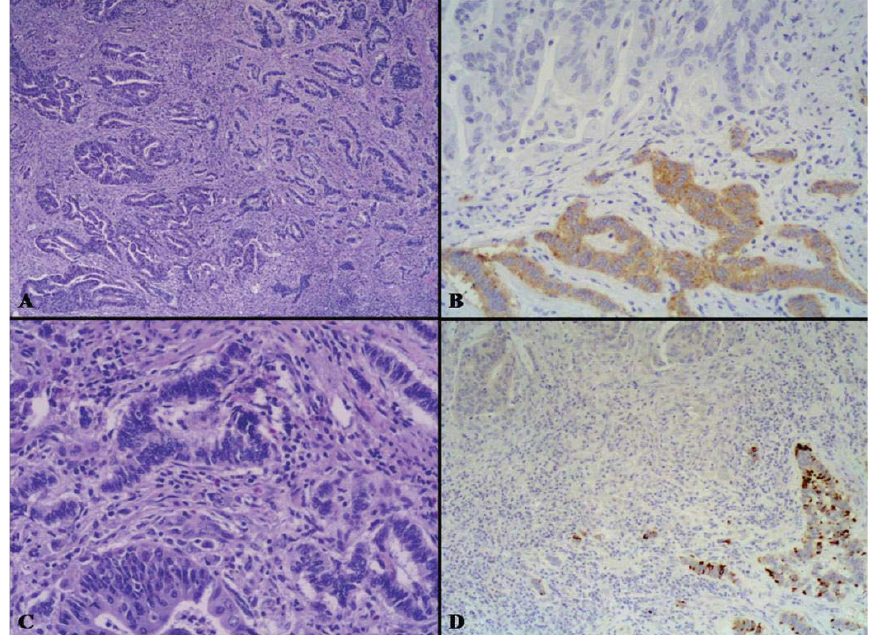
Figure 8. The intermediate grade MANEC category includes mixed adenocarcinomas-NETs which are formed by areas of adenocarcinoma and areas of grade 1 or 2 NET. In ( A ) the tubular adenocarcinoma component is evident on the left, while the NET showing a trabecular pattern of growth is observed on the right. The neuroendocrine component is immunoreactive for synaptophysin ( B ) and is characterized by well differentiated neuroendocrine cells without significant atypia growing in trabecular structures ( C ) negative for Ki67, which is conversely well expressed in the adenocarcinomatous areas ( D ).